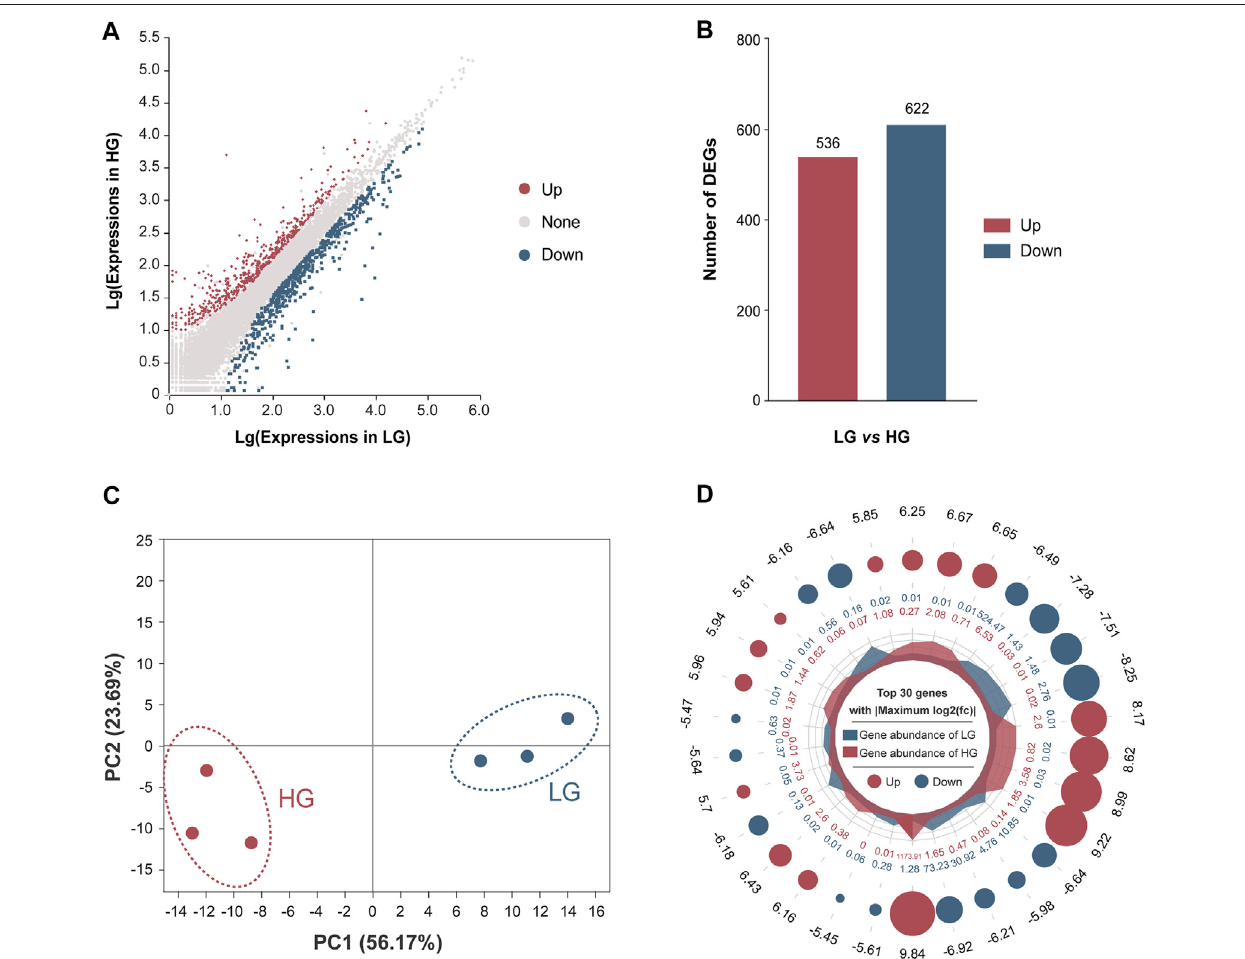
FIGURE3| Comparisonofdifferentiallyexpressedgenes(DEGs)betweenthehighergrowth(HG)andlowergrowth(LG)groupsofNiletilapia,withtheLGgroupas the control. (A) M-versus-A plot (MA plot) of DEGs of the HG versus the LG group. (B) Numbers of DEGs between the LG and HG groups, with LG as the control group andHGasthecomparisongroup,withlog 2 foldchange(FC)of ≥ 2or ≤ 0.5( p < 0.01). (C) PrincipalcomponentsanalysisoftheHGandLGgroupsbasedonexpressionof all annotated genes. (D) Ploidy radar plot of the top-30 signi fi cantly different genes between the HG and LG groups. The numbers in the outermost circle are the differentialmultiplesofgenes;redandbluedotsrepresentupregulationanddownregulation,respectively;alargercirclediameterrepresentsalargerabsolutevalueofthe multiples; the inner red and blue numbers represent the gene abundance within the HG and LG groups, respectively.